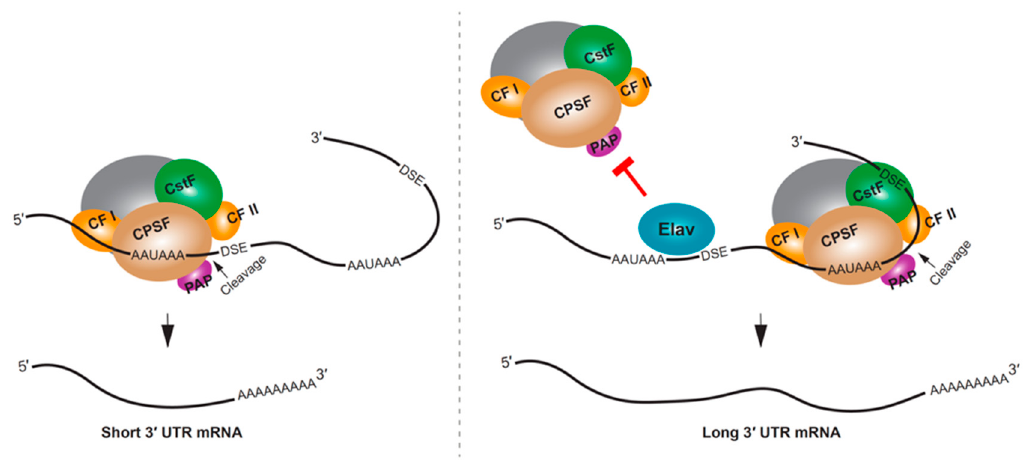
Figure 3. Mechanisms of neural APA in Drosophila . The neuronal RBP Elav regulates APA by binding to target mRNA proximal poly(A) site region to block the 3 ′ end processing machinery. This promotes the usage of downstream distal poly(A) sites. Consequently, neuronal tissues of Drosophila selectively express APA isoforms with longer 3 (cid:48) UTRs. DSE, downstream element; AAUAAA is shown as a representative polyA